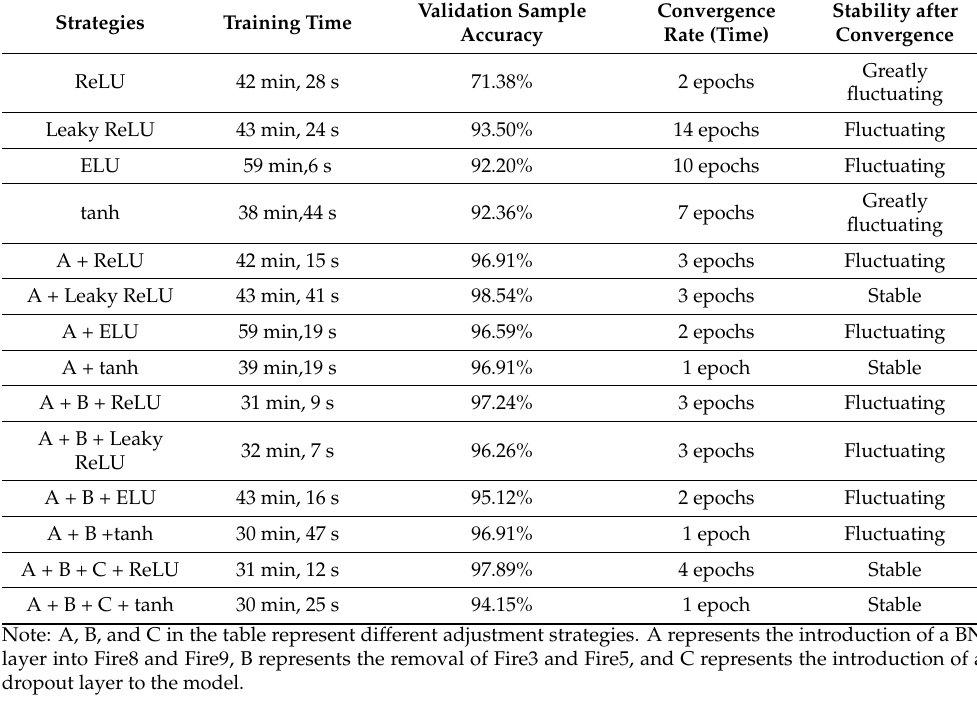
Table 4. Comparison of the effects of individual tuning strategies based on a simple bypass connec- tion.